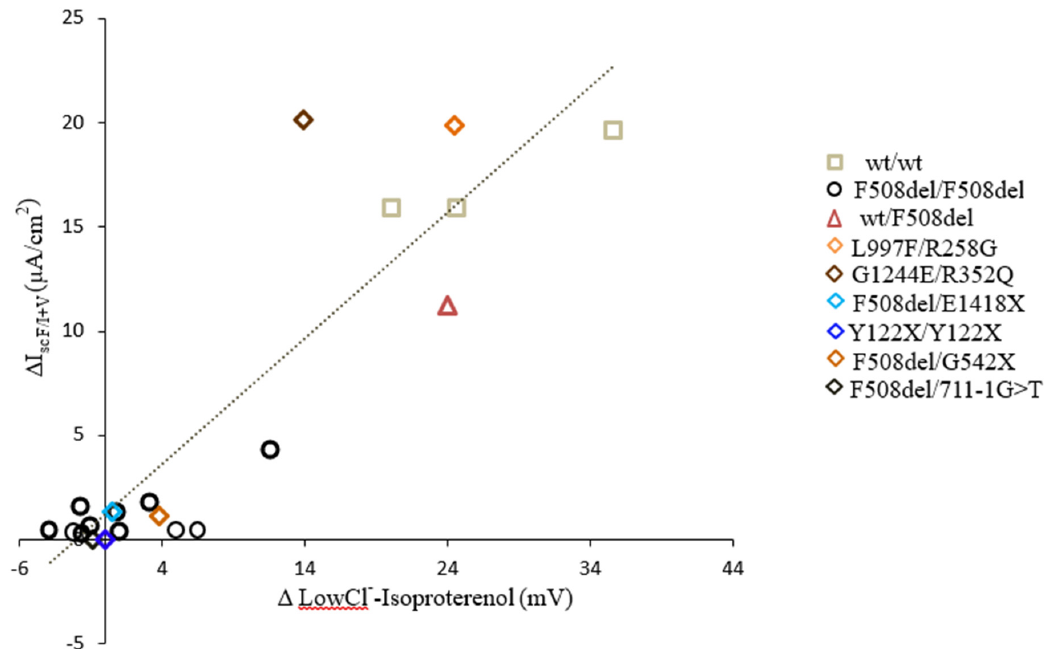
Figure 3. Correlation between cAMP-activated chloride transport in the nasal mucosa by the NPD ( ∆ LowCl − -Isoproterenol (mV) and in the primary cell culture from nasal brushing ( ∆ I sc F/I+V ( µ A/cm 2 ) in the same